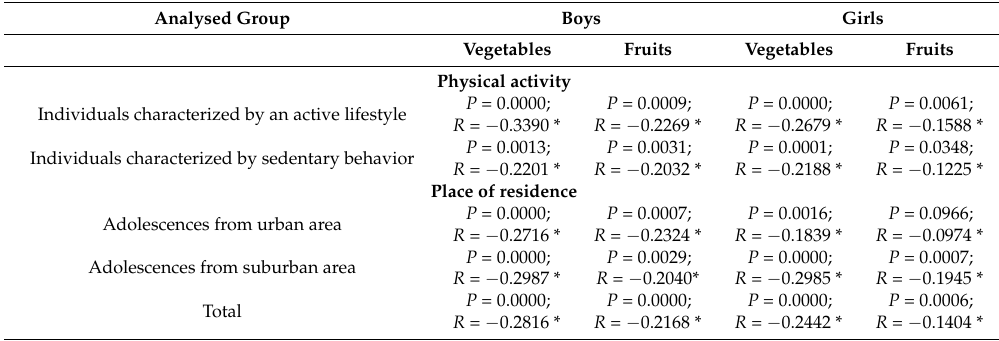
Table 5. Analysis of correlations between calculated food neophobia levels and vegetable or fruit intake ( n = 1014). Analysed Group Boys Girls Vegetables Fruits Vegetables Fruits Physical